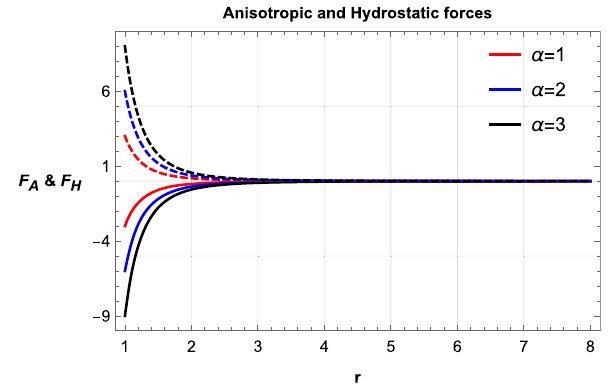
Fig. 19 Hydrostatic (plane lines) and anisotropic (dashed lines) forces for two sphere (case-1) with r 0 = 1 and A = 0 . 05